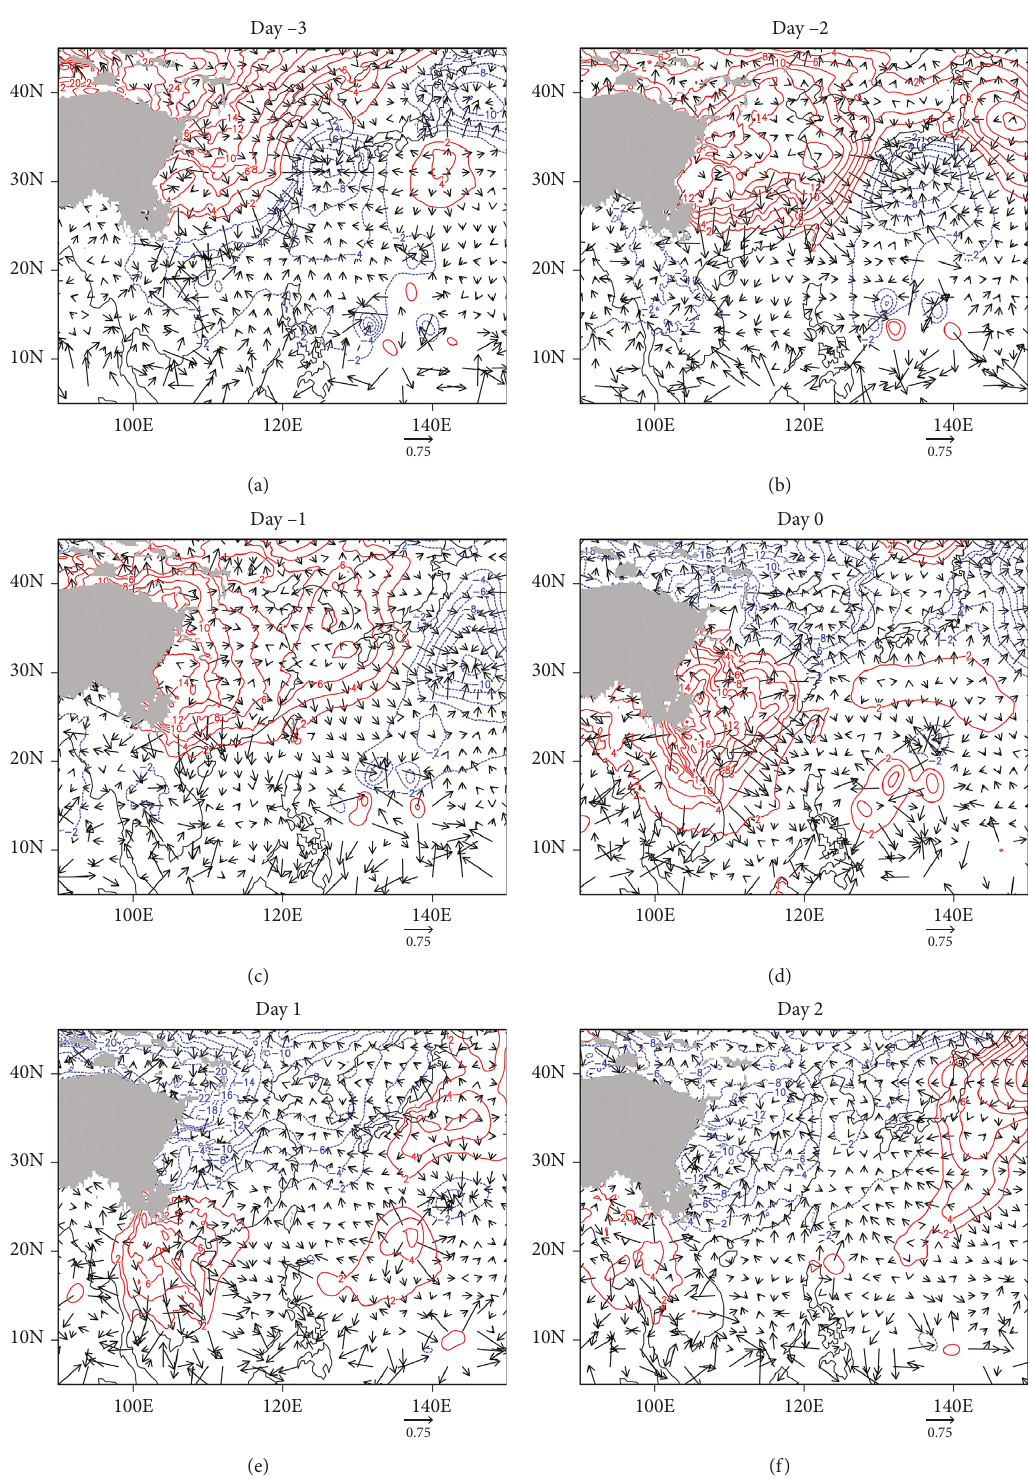
Figure 8: Composite of time rate change mean sea level pressure ( contour , m) and isallobaric wind ( vector , ms − 1 ) during the events associated with cold surge and low-level vortex. The areas where the land elevation is higher than 1500m are shaded